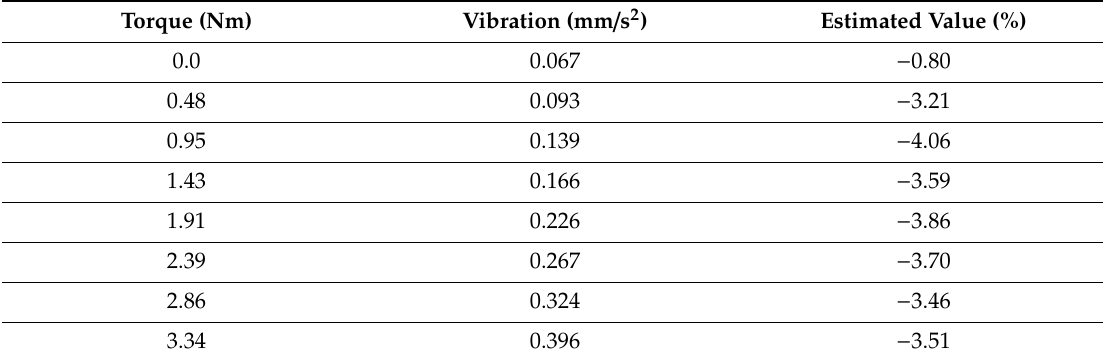
Figure 14. How to estimate the demagnetization level using the measured torque T and vibration V . Table 4. Estimation of the demagnetization level of a radially demagnetized PM using the 12th vibration component.